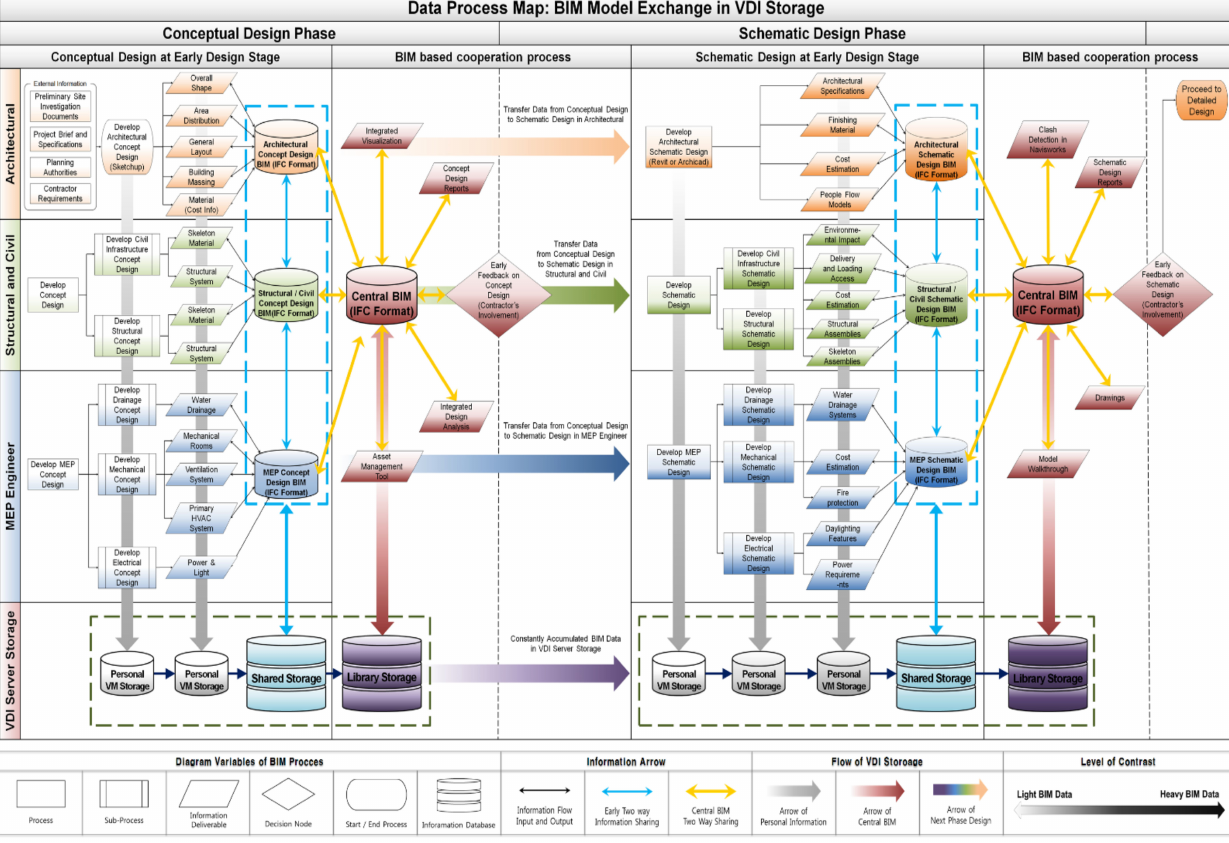
Figure 3. Information flow process of BIM-based project (BIM data weights and share flow